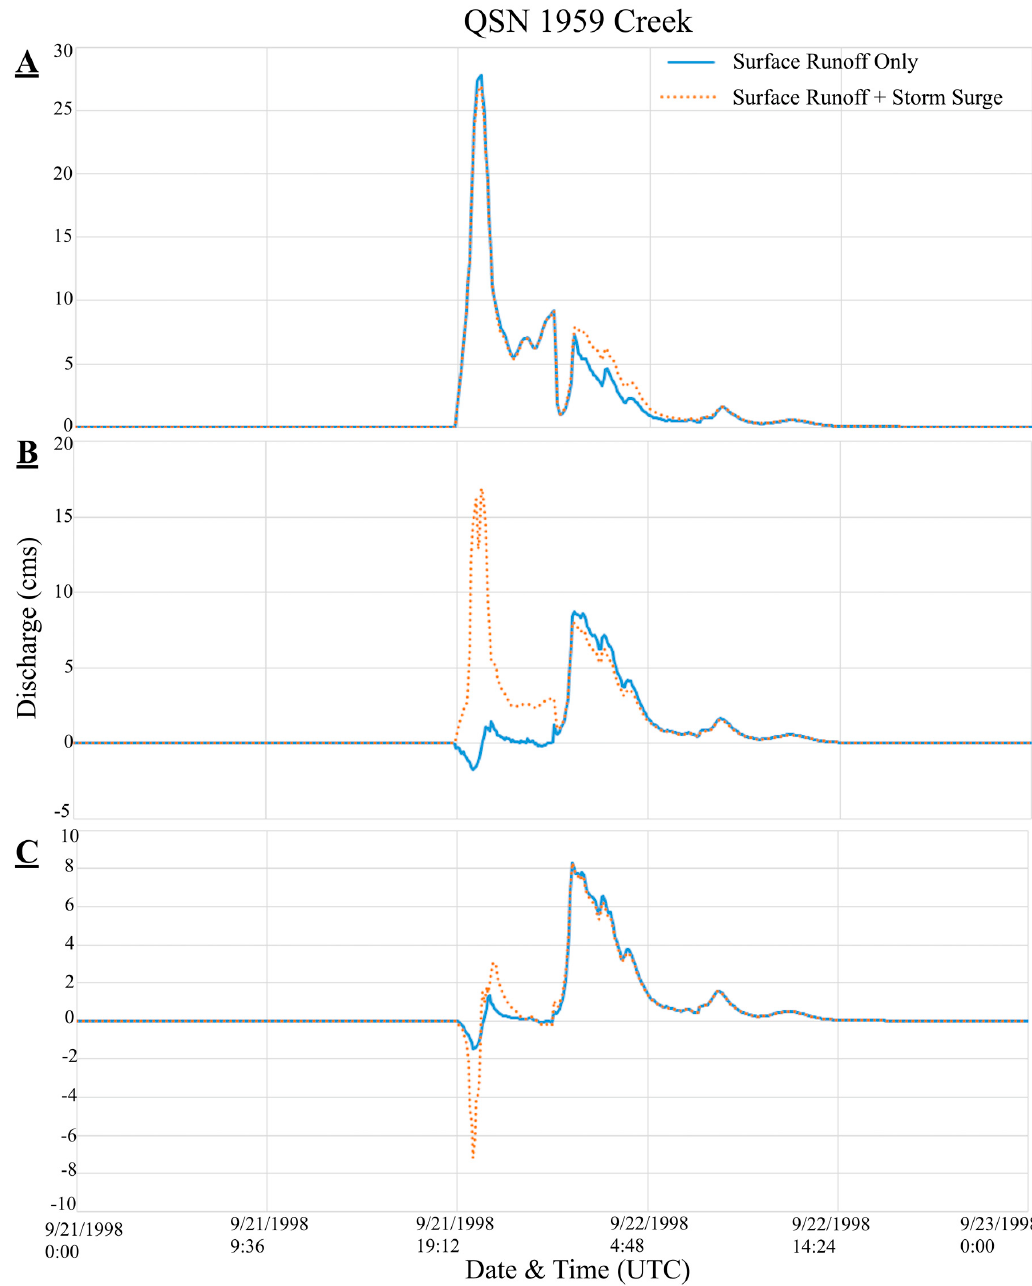
Figure 15. Discharge hydrograph for the different flooding scenario and at different locations for the QSN 1959 Creek watershed. ( A ) At 0-m from the stream outlet; ( B ) At 50-m from the stream outlet; ( C ) At 100-m from the stream outlet. The “Surface Runoff + Storm Surge” flooding scenario is represented with orange dots line and the “Surface Runoff Only” flooding scenario is represented with a solid blue line. The discharge is expressed in cubic meters per second (cms).